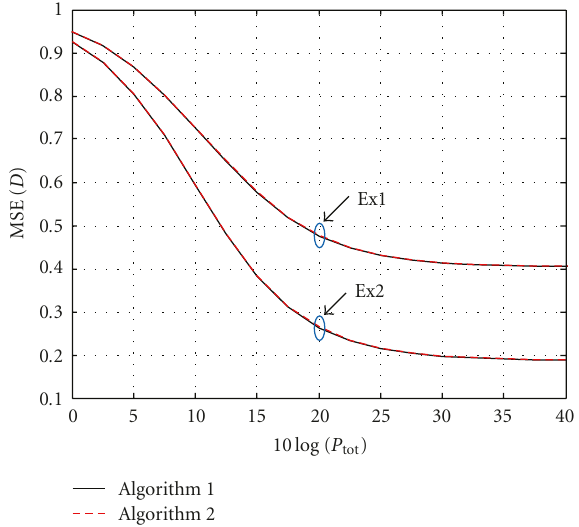
Figure 5: Performance comparison of the APA